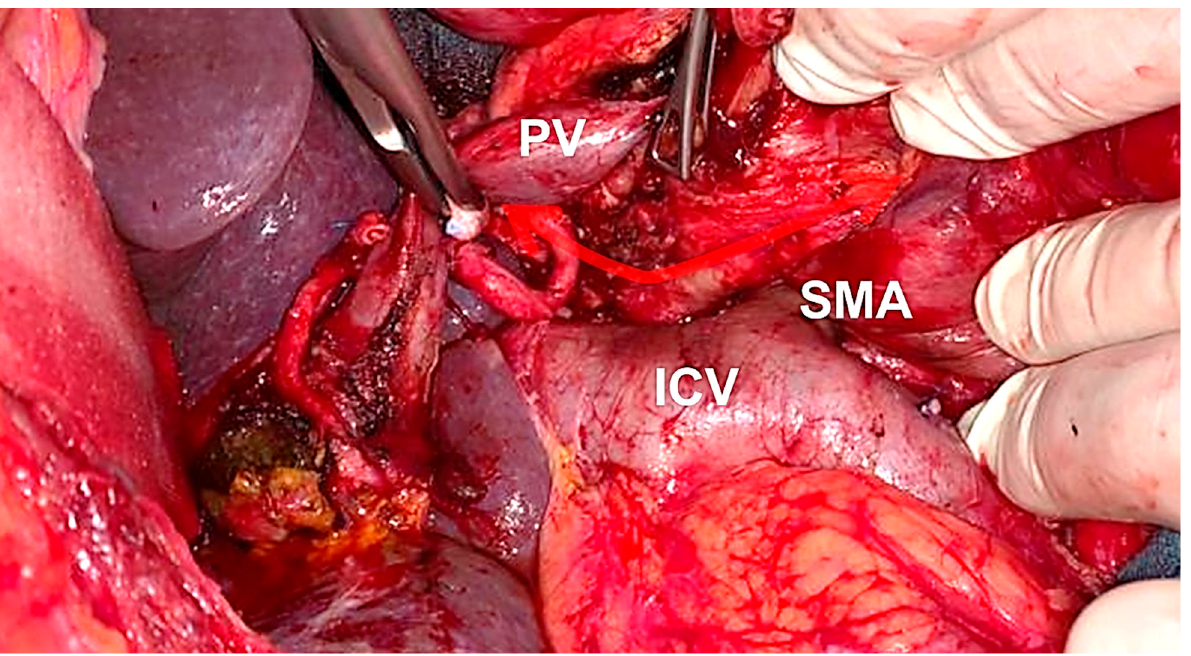
Figure 2. Intraoperative picture of situs during MPE. Note the strict dissection around the caval vein (ICV) and abdominal aorta until the origin of the superior mesenteric artery (SMA) and celiac trunk (red arrow). (ICV, inferior caval vein, PV: portal vein, SMA: superior mesenteric artery). All resections were performed by trained hepatobiliary surgeons of our department.